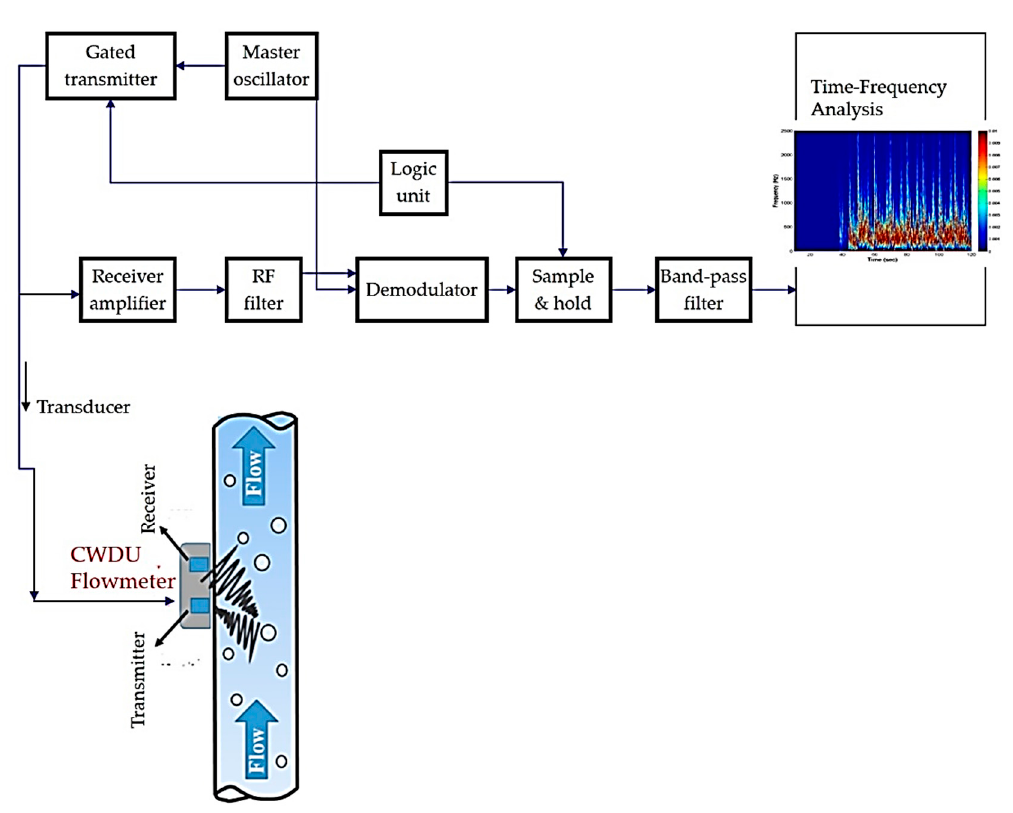
Figure 2. Continuous-wave Doppler ultrasound system hardware block diagram